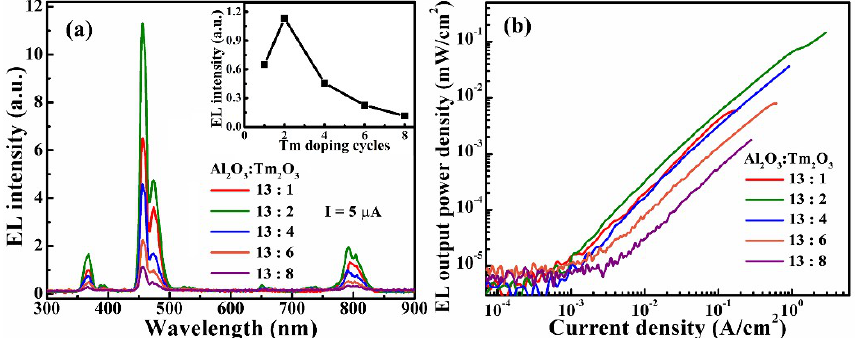
Figure 3. ( a ) EL spectra from the MOSLEDs based on the Al 2 O 3 /Tm 2 O 3 films with different Tm dopant cycles at an injection current of 5 µA, the inset shows the tendency of this EL intensity with the Tm dopant layers. ( b ) The dependence of the 456 nm EL power density on the injection current density for the Al 2 O 3 /Tm 2 O 3 MOSLEDs with different Tm dopant cycles.